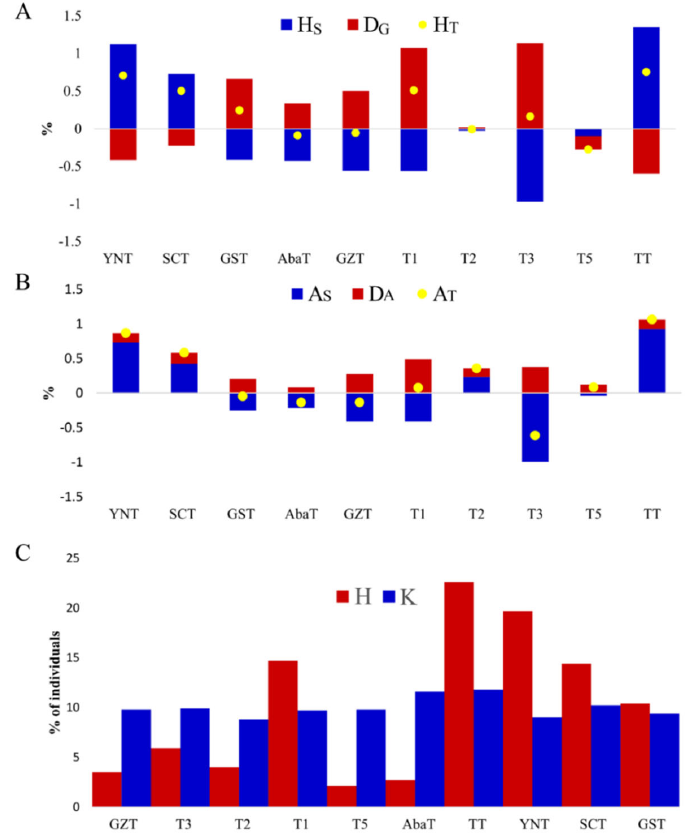
Figure 4. Contribution to genetic diversity of 10 Tibetan pig populations. Contribution to gene diversity ( A ) and allele diversity ( B ) H S and A S indicate within-population gene and allele diversity, respectively. D G and D A indicate between-population gene and allele diversity, respectively. H T and A T indicate total gene and allele diversity, respectively. Contribution of individuals from each population to a pool with maximal gene diversity (H) and allele diversity (K) ( C ).